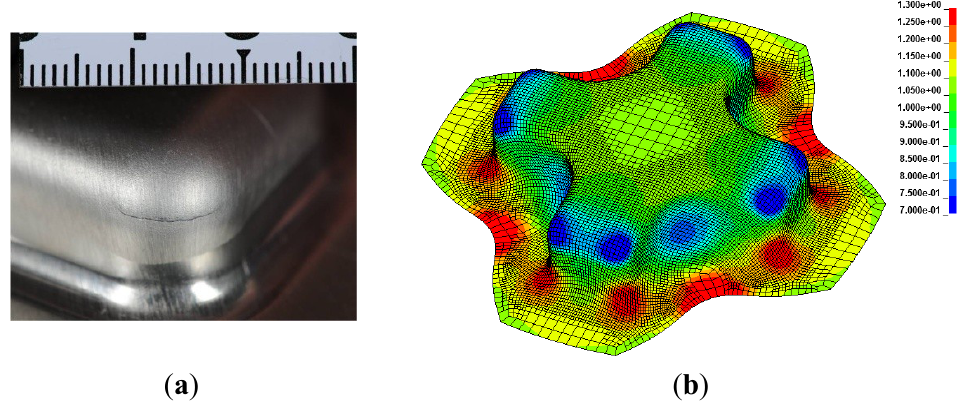
Figure 12. The appearance of a crack due to thinning on the corners of the cross-die sample: ( a ) experiment and ( b ) simulation of the material thinning in (mm).